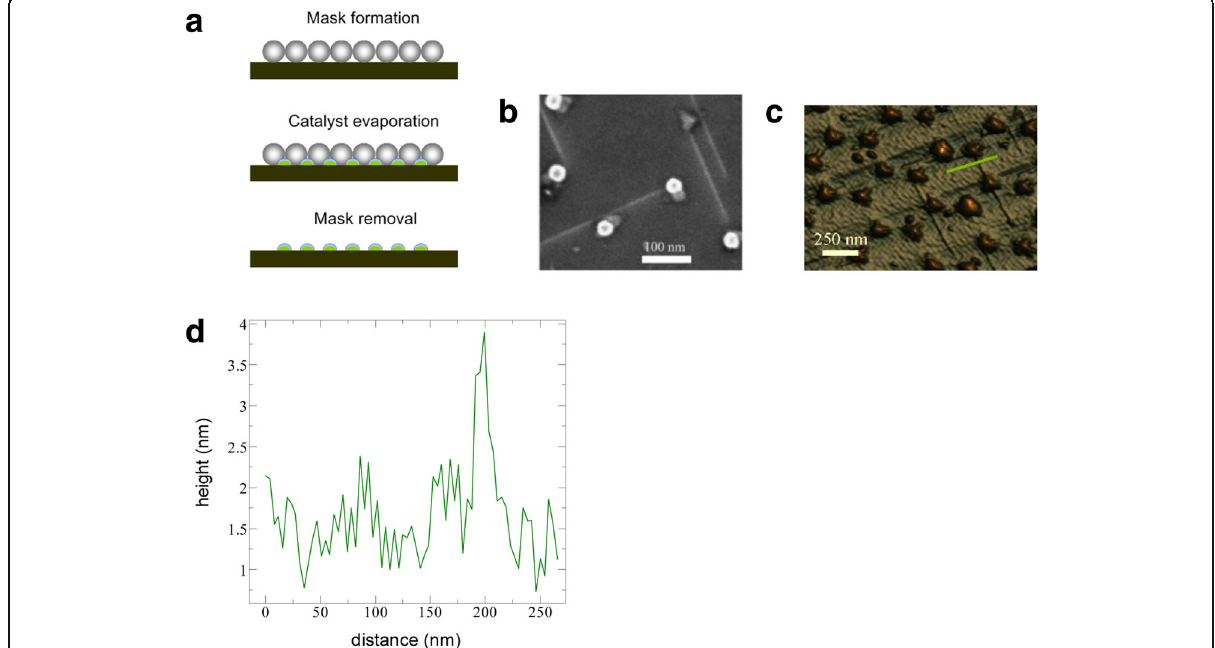
Fig. 26 a Schematic of steps involved in fabrication of patterned catalyst array on undoped Si substrates using colloidal lithography. The spheres represent polystyrene spheres with a diameter of 450 nm. Adapted from [197]. b SEM image of the individual SWCNTs connected between catalyst patterned nanoparticle arrays. Adapted from [197]. c , d AFM image of individual SWCNTs with diameter of ~2 nm. Adapted from [197]. Green line shows the d corresponding cross-section. Adapted from